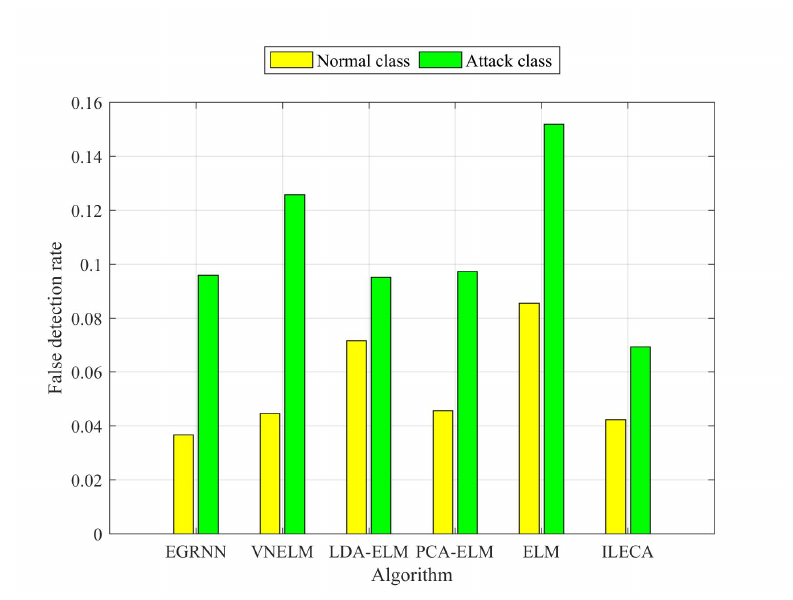
Figure 14. False detection